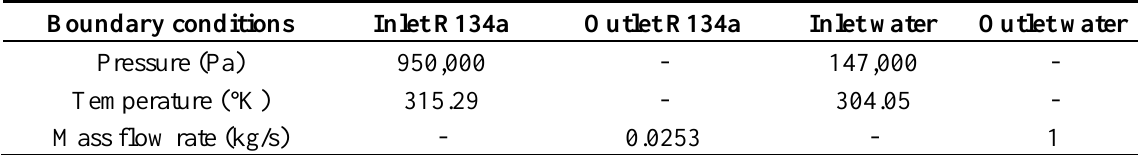
Table 10. Simulation boundary